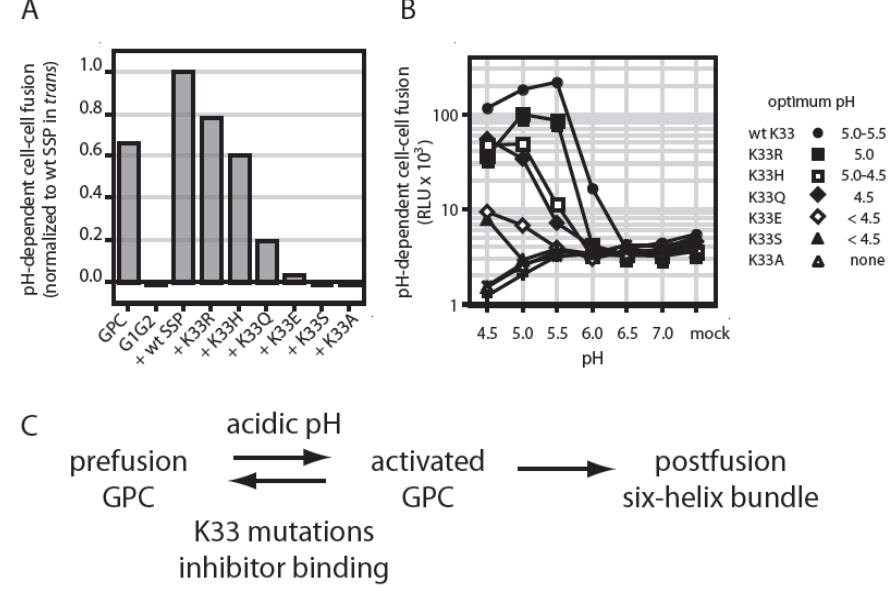
4. K33 in SSP modulates pH-induced activation of membrane fusion. ( A ) Mutations that reduce positive polarity at SSP K33 were introduced into SSP and the membrane-fusion activity of the GPC complex was determined in our standard assay for cell-cell fusion. All SSPs were expressed in trans with the G1G2 precursor to reconstitute GPC, and fusion activity was normalized to that of the wild-type (K33) SSP. GPC and G1G2 indicate, respectively, the complete GPC open-reading frame and the precursor alone, in the absence of SSP. ( B ) The pH-dependence of the mutant GPC complexes was determined by varying the pH of the triggering pulse of acidic medium. The nominal optimal pH for each mutant is listed at right. ( C ) Model for pH-induced activation of GPC, and its inhibition by mutations at K33 and by small-molecule compounds. Acidic pH destabilizes the metastable prefusion GPC complex to favor an activated state, that spontaneously undergoes the class I structural reorganization resulting in formation of the six-helix bundle and membrane fusion. By contrast, K33 mutations and inhibitor binding disfavor the transition to the activated state. The molecular basis for maintaining the equilibrium between prefusion and activated states is